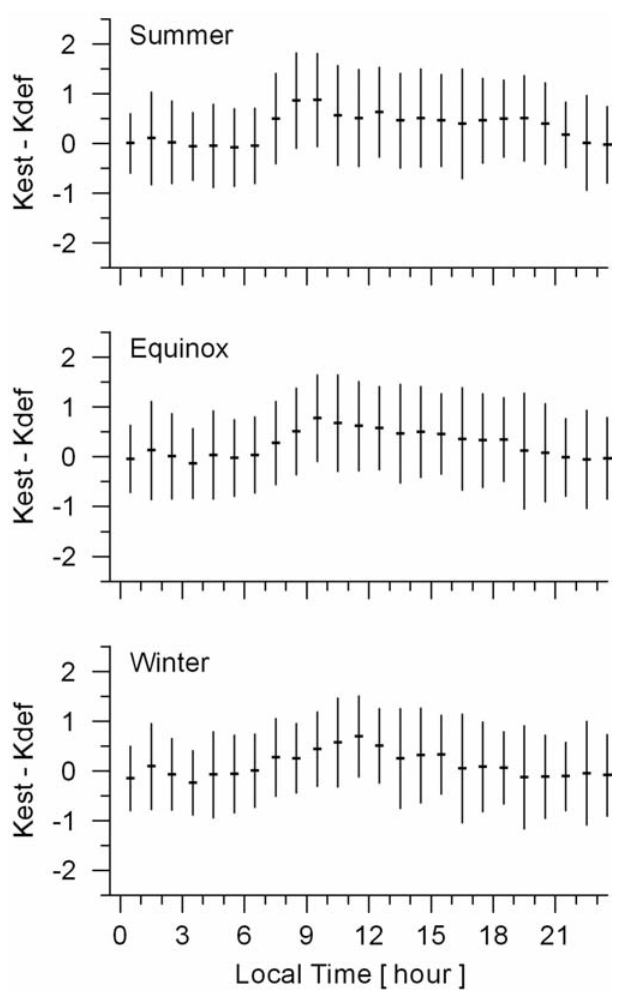
Figure 7. Evaluation of the K index nowcast for the period 2002-2008, for Dourbes. Diurnal variations of the differences between Kest and Kdef for the three seasons (as indicated). The mean values for each hour are shown (+), with the corresponding standard deviations (vertical